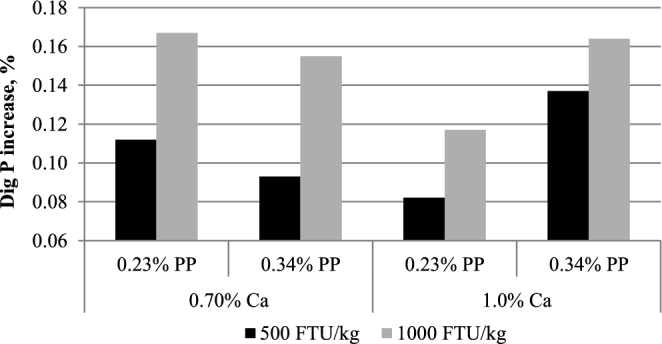
Impacts of Ca and PP on phytase efficacy expressed as digestible P increase. Phytase efficacy was calculated as: Dig P increase (%) = (Pdigphy—Pdignon-phy) × Pdiet. Dig P increase, net increase in digestible P; Pdigphy, P digestibility in birds fed phytase diets; Pdignon-phy, P digestibility in birds fed non-phytase diets with same Ca and PP; Pdiet, analyzed total P concentration in the diet.